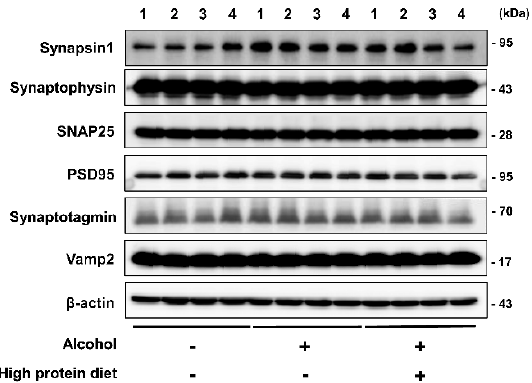
Figure 4. Expression of synaptic neuron in alcohol induced high protein diet group. Representa- tive Western blot of mouse hippocampus homogenate.